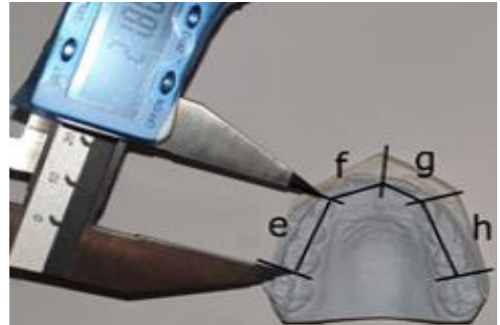
Figure 1. Measurement of the available space on maxillary cast: e = length between the mesial contact point of the upper right first permanent molar and the mesial contact point of the upper right canine, f = length between mesial contact point of the upper right canine and the midline; g = length between the midline and the mesial contact point of the upper left canine; h = length between the mesial contact point of the upper left canine and the mesial contact point of the upper left first permanent molar.